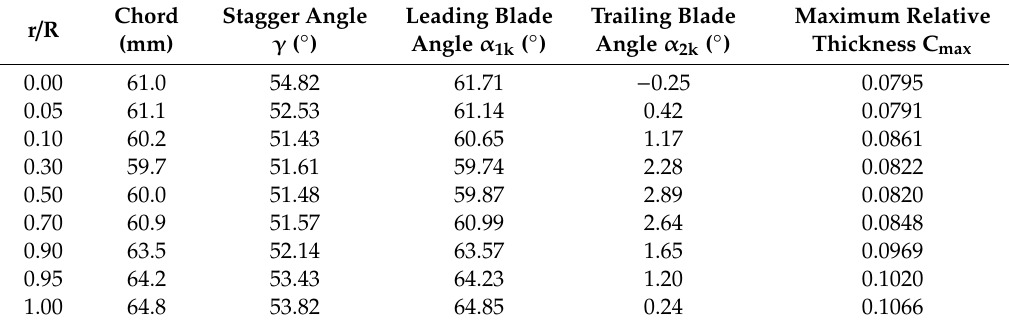
Table 2. Geometric parameters of the